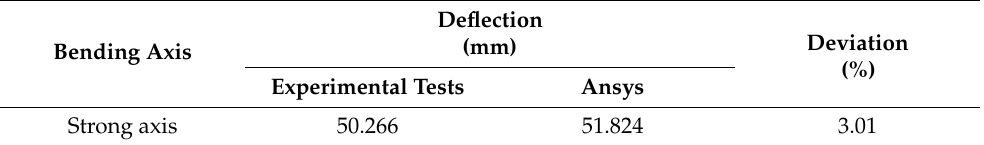
Table 3. Comparison of beam deflection between experimental tests and